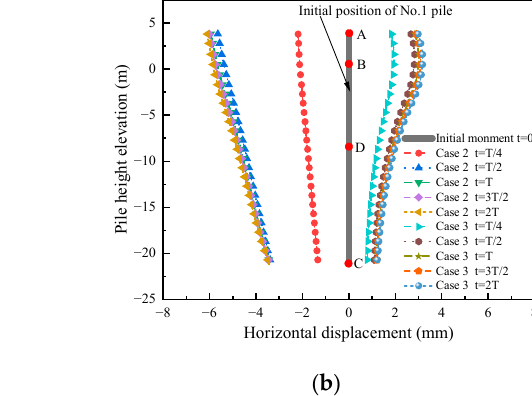
sudden drop of the water level, which is the most unfavorable case among the three cases.